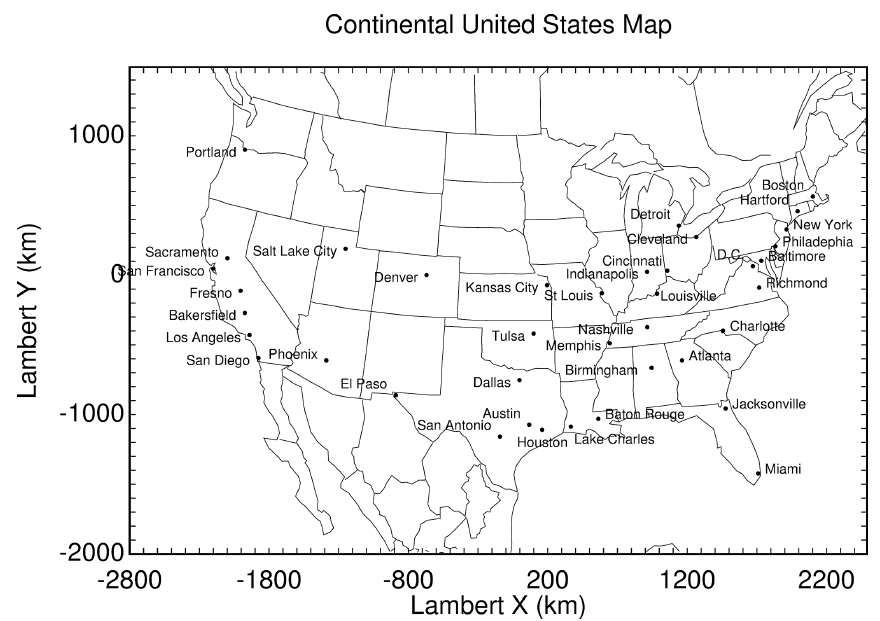
Figure 1. Map of 39 cities used for the prediction of PM 2 . 5 and PM 0 . 1 source contributions across the continental United States during summertime air pollution